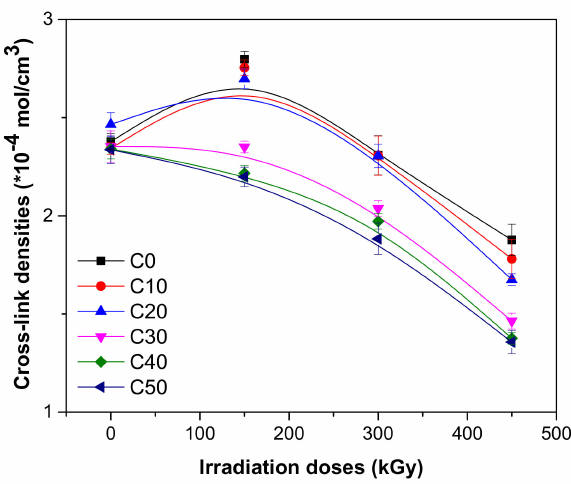
Figure 5. Cross-link density variation as a function of EB irradiation dose and PS